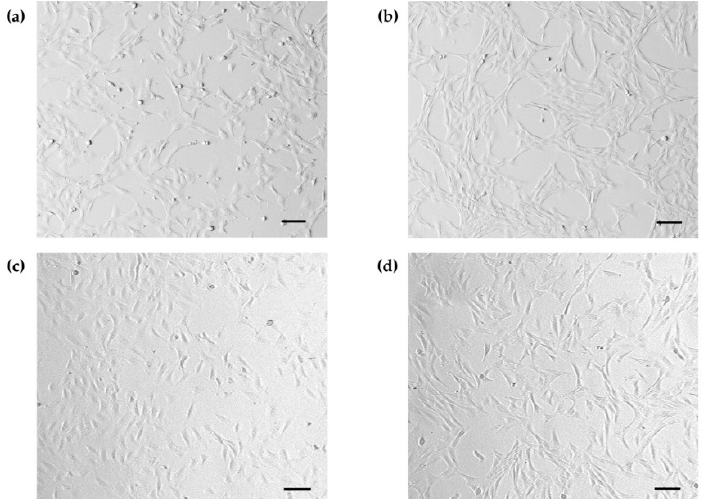
Figure 1. Microscopic images of different auditory hair cell states. Undifferentiated UB/OC − 1 ( a ) and UB/OC − 2 ( b ) cells were cultivated at 33 °C, whereas differentiating UB/OC − 1 ( c ) and UB/OC − 2 ( d ) cells were incubated at 39 °C for at least 14 days. The scale bar corresponds to 100 µm. Specific hair cell markers were detected to verify differentiation by performing qPCR. Table 1. Upregulation of hair cell markers through cell